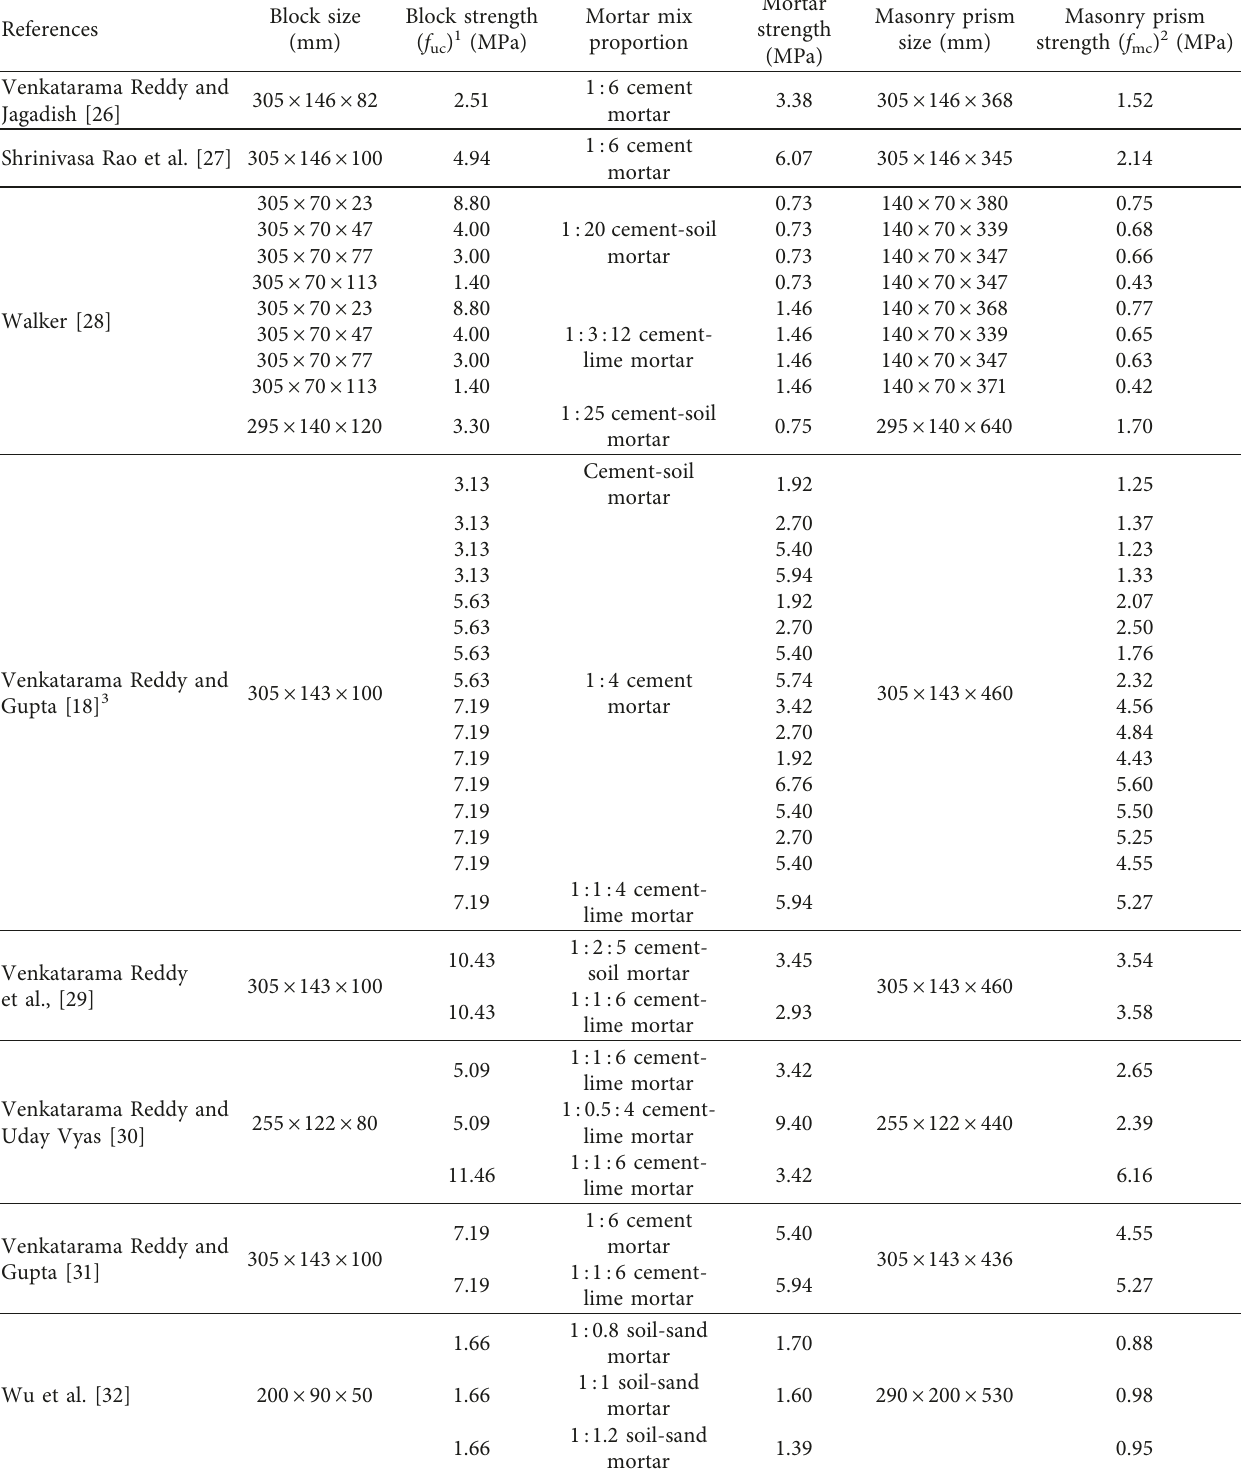
Table 9: Experimental data from published in